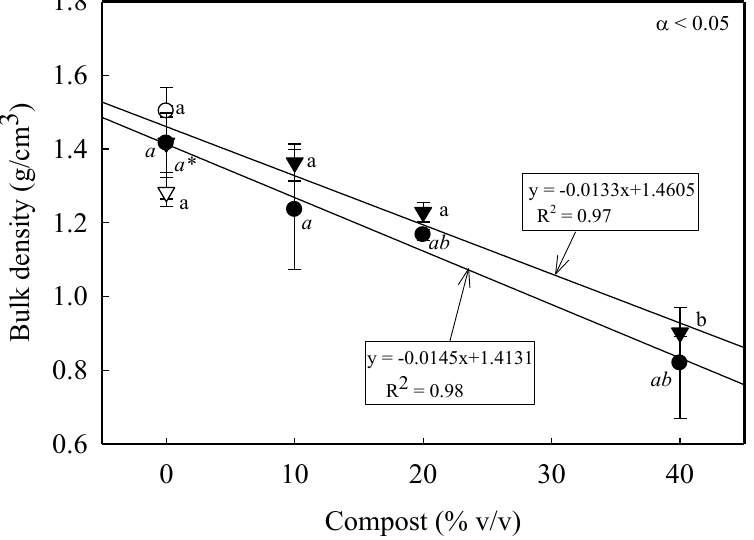
Figure 4. Effect of incorporating composted poultry litter into top 12.7 cm of subsoil on soil bulk density for ● sodded compost; ○ sodded fertilizer; ▼ seeded compost; and seeded fertilizer plots; * Means with same letters are statistically insignificant based on Fisher’s Protected LSD test ( P ≤ 0.05) (italicized statistics correspond to sodded treatments).